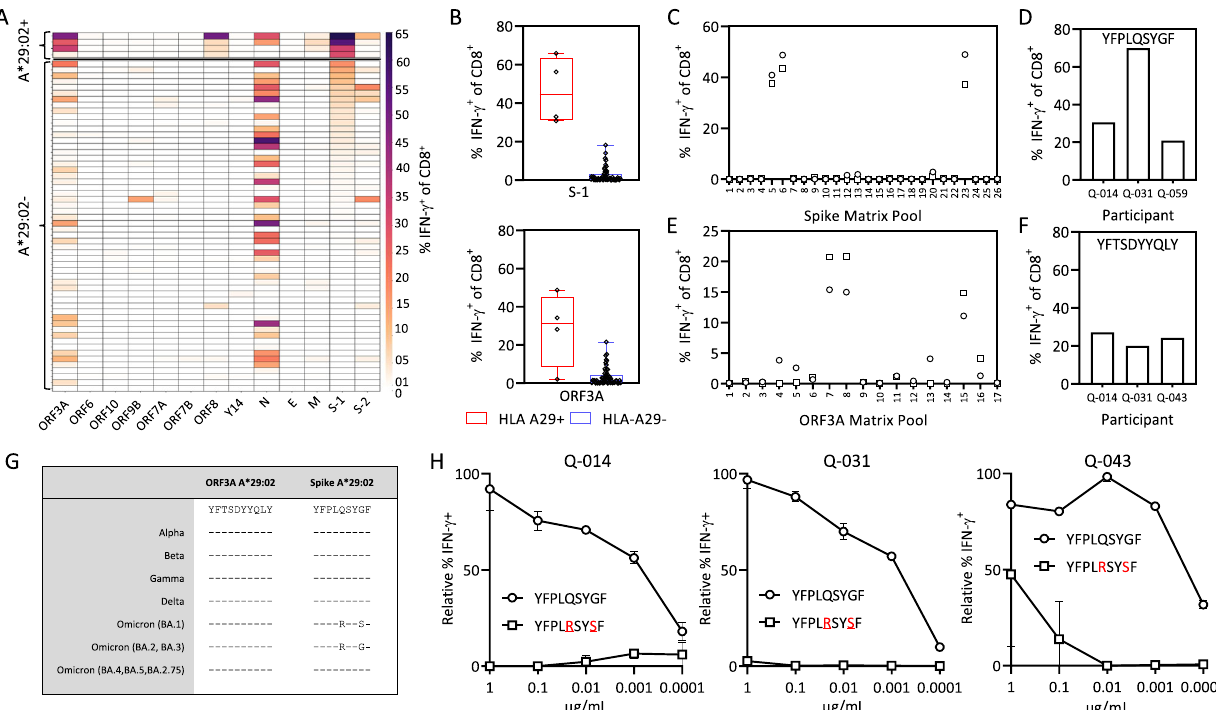
Fig. 1 | Immunodominant HLA-A*29:02-restricted T cell immunity in COVID-19 convalescent participants. SARS-CoV-2 speci fi c T cells from COVID-19 con- valescent participants were expanded from PBMC using SARS-CoV-2 encoded antigens. PBMCswerecultured for2weeksinthepresenceofIL-2andassessed for IFN-g responses following recall with the speci fi c antigen. A Heatmap of the mag- nitude of SARS-CoV-2 antigen-speci fi c T cell responses in COVID-19-convalescent individuals (HLA-A*29:02 + , n =4; HLA-A*29:02 - , n =55). B Frequency of S-1- and ORF3A-speci fi c IFN- γ -producing CD8 + T cells in HLA-A*29:02 + and HLA-A*29:02 – participants. Whiskers represent minimum to maximum values, boxes represent the 25th to 75th percentile, line represents the median. C Frequency of IFN- γ -